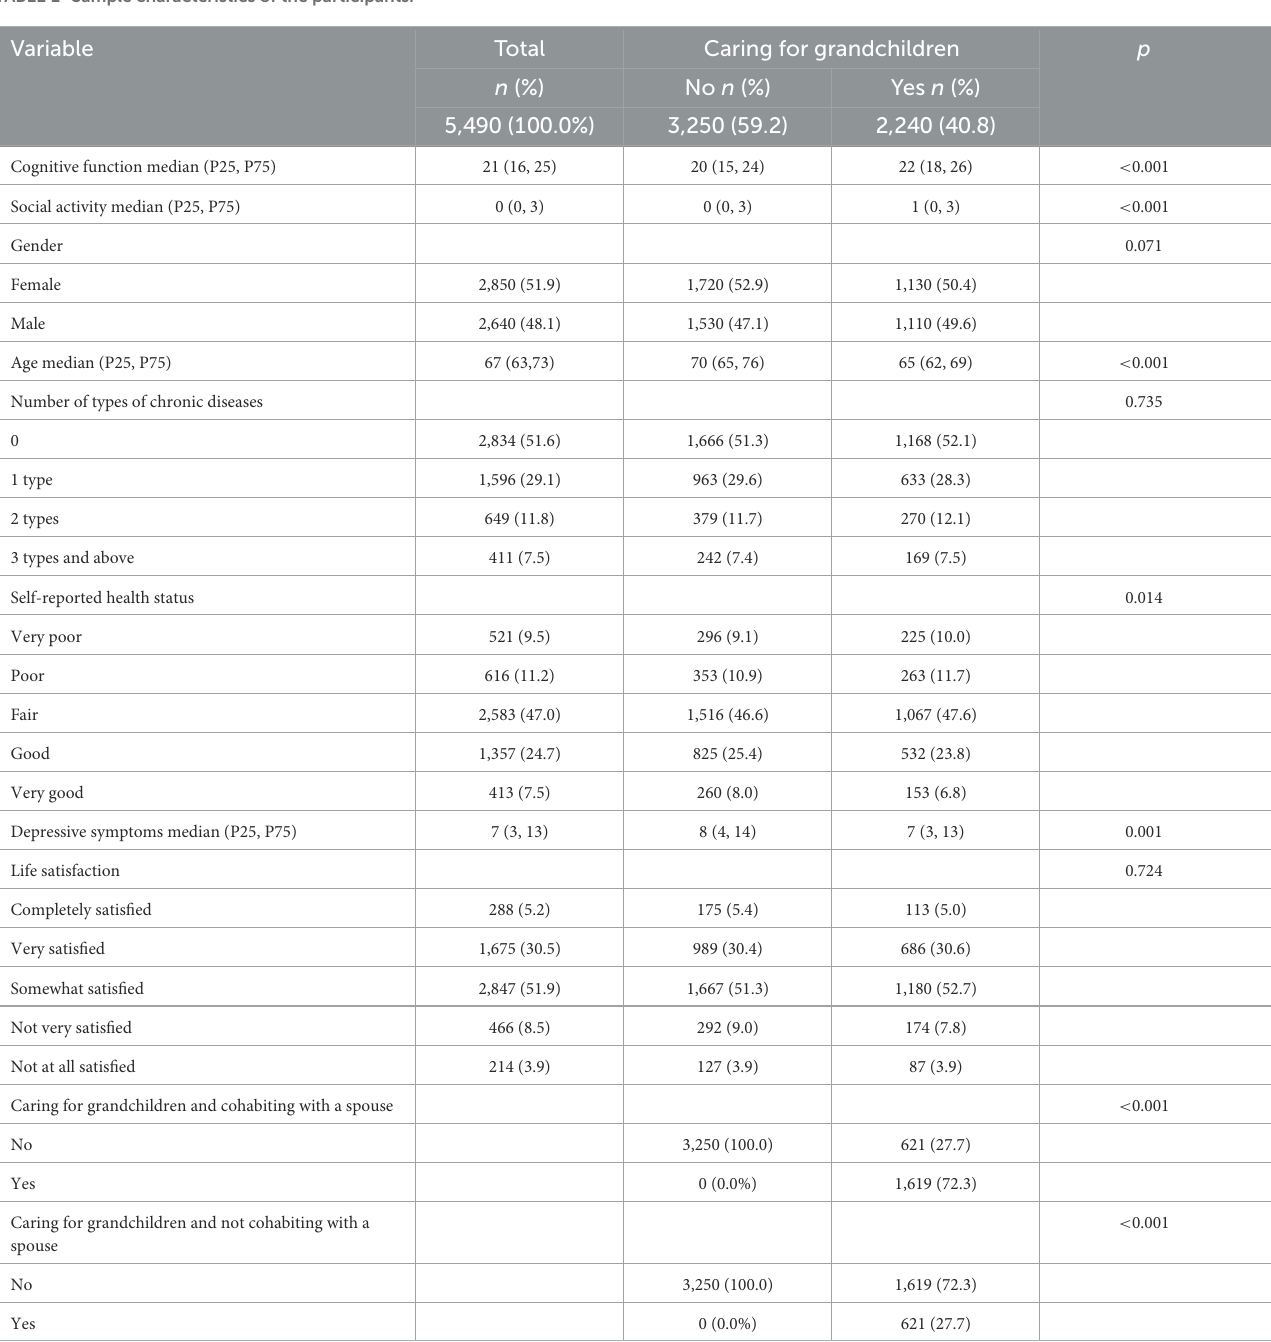
TABLE 1 Sample characteristics of the